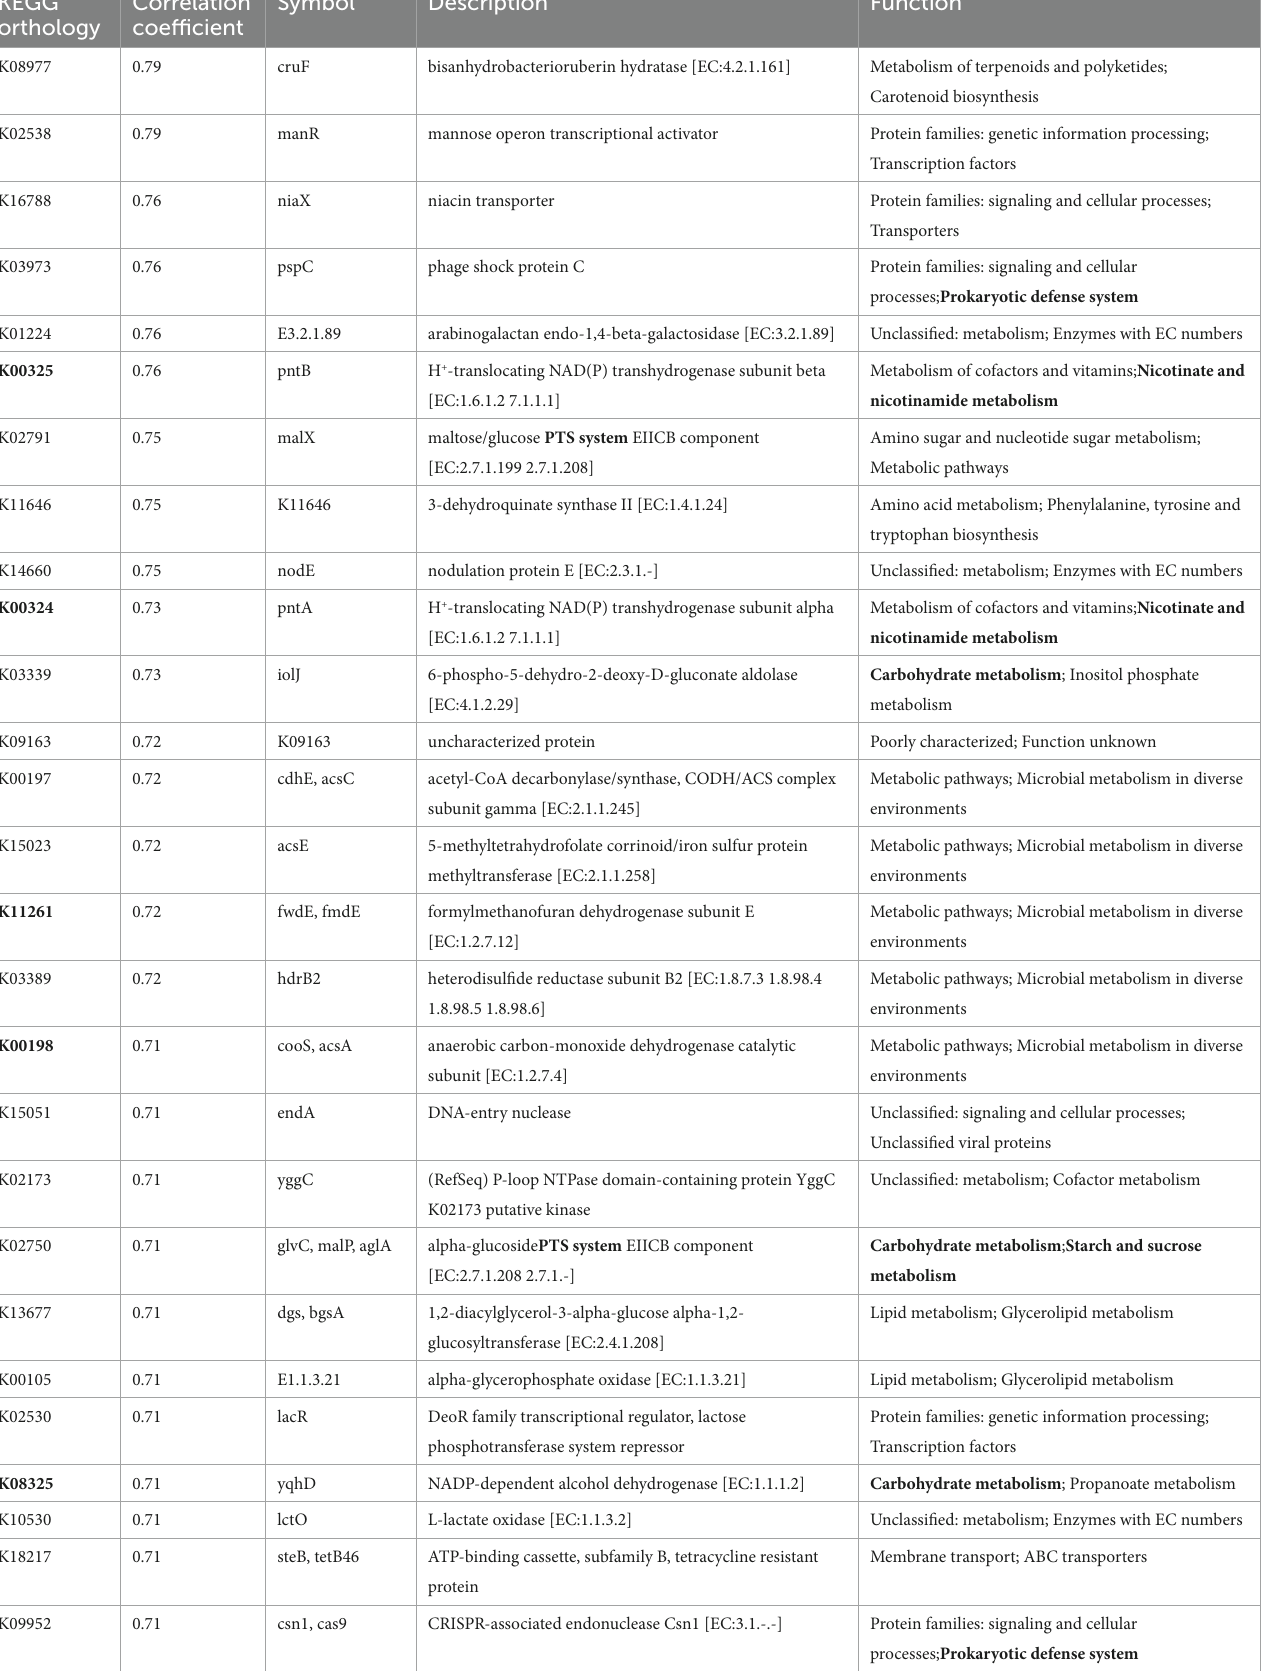
TABLE 1 KEGG orthologies predicted by PICRUSt2 correlated with changes in dyeing intensity (correlation coefficient ≥ 0.69). KEGG Correlation orthology